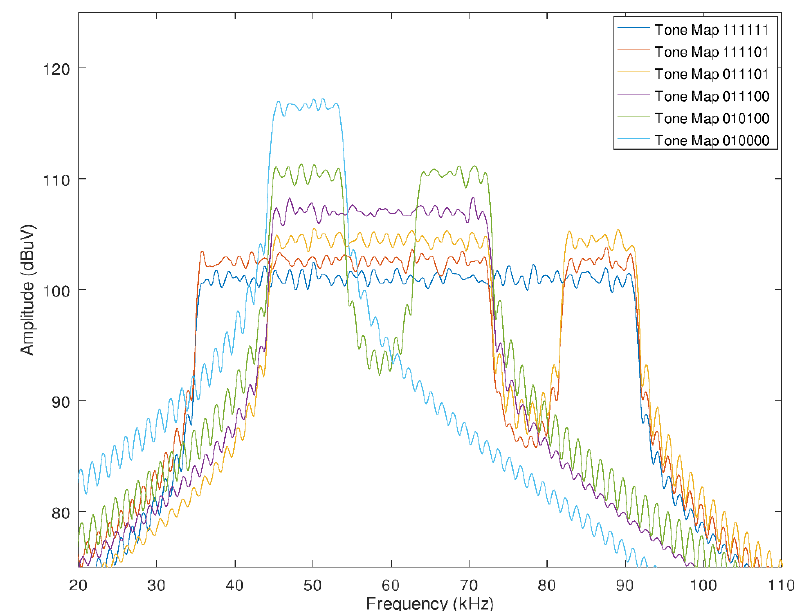
Figure 5. Payload spectral evolution using tone map power reallocation with 500 Hz frequency resolution and a total transmission power of 120 dBµV.